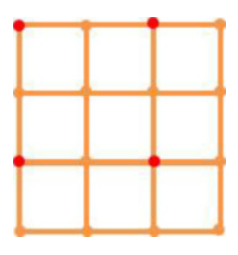
Fig. 1 Schematic diagram of degradation